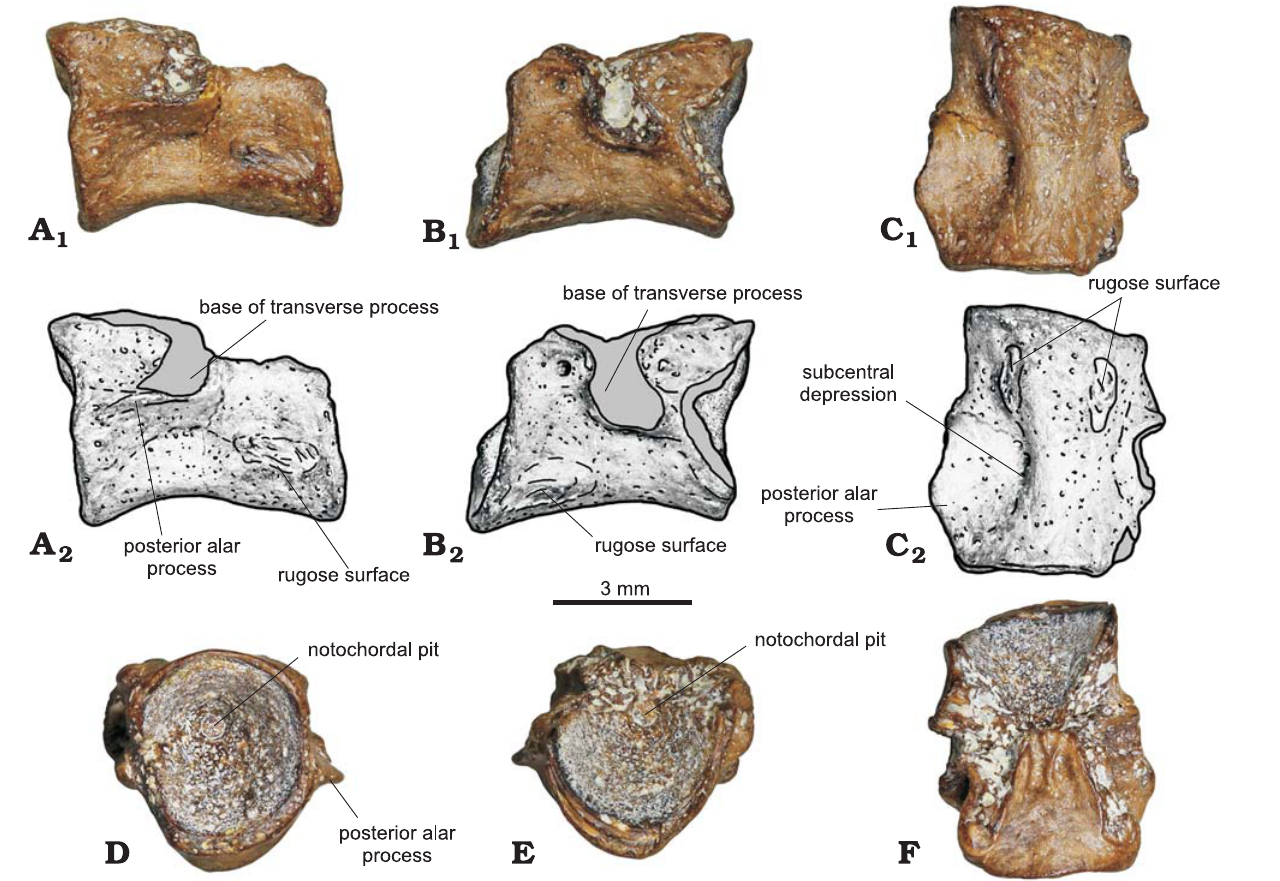
Fig. 1. Fragmentary trunk vertebral centrum (LMCCE 1/4) of stem salamander Caudata, gen. et sp. indet. from the Shestakovo locality, Lower Cretaceous (Aptian–Albian), Ilek Formation, Western Siberia, Russia; in right lateral ( A ), left lateral ( B ), ventral ( C , anterior towards top), posterior ( D ), anterior ( E ), and dorsal ( F , anterior towards top) views. Photographs (A